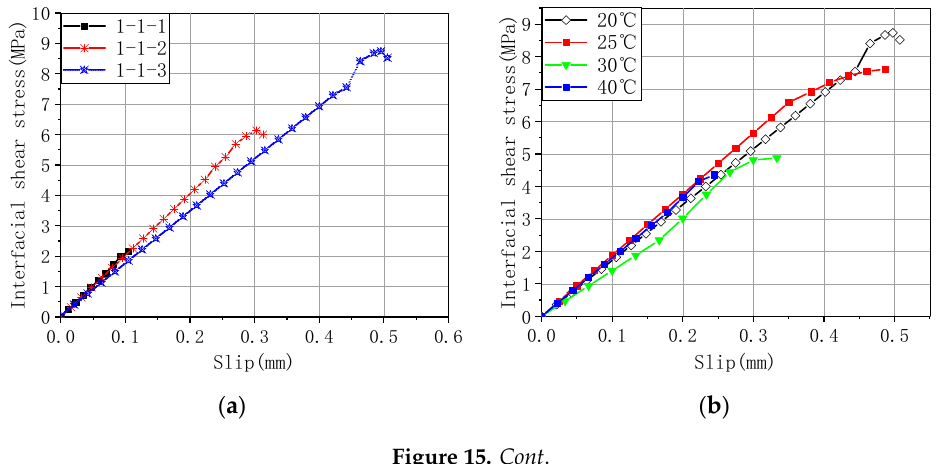
( e ) Figure 15. Interfacial shear stress and slip of CFRP bonding concrete arch. ( a ) Shear stress and slip curves for different CFRP lengths, ( b ) shear stress and slip curves for different, T.; ( c ) shear stress and slip curves for different CFRP layers, ( d ) shear stress and slip curves for different H, ( e ) maximum interfacial shear stress and slip curves for hygrothermal coupling. Figure 15 shows the relationship between shear stress and the slip under different environments. For the strengthened specimens of differently longitudinal CFRP, the shear stress is linearly dependent on the slope as the load increases until it fails. Furthermore, the relationship between the ultimate slope and the length is almost proportional. With an increase in the number of CFRP layers, the stress–slope relation is gradually nonlinear after the load value reaches 80%, and the stress–slope curve is more nonlinear with increasing temperature or humidity than the curve shape with an